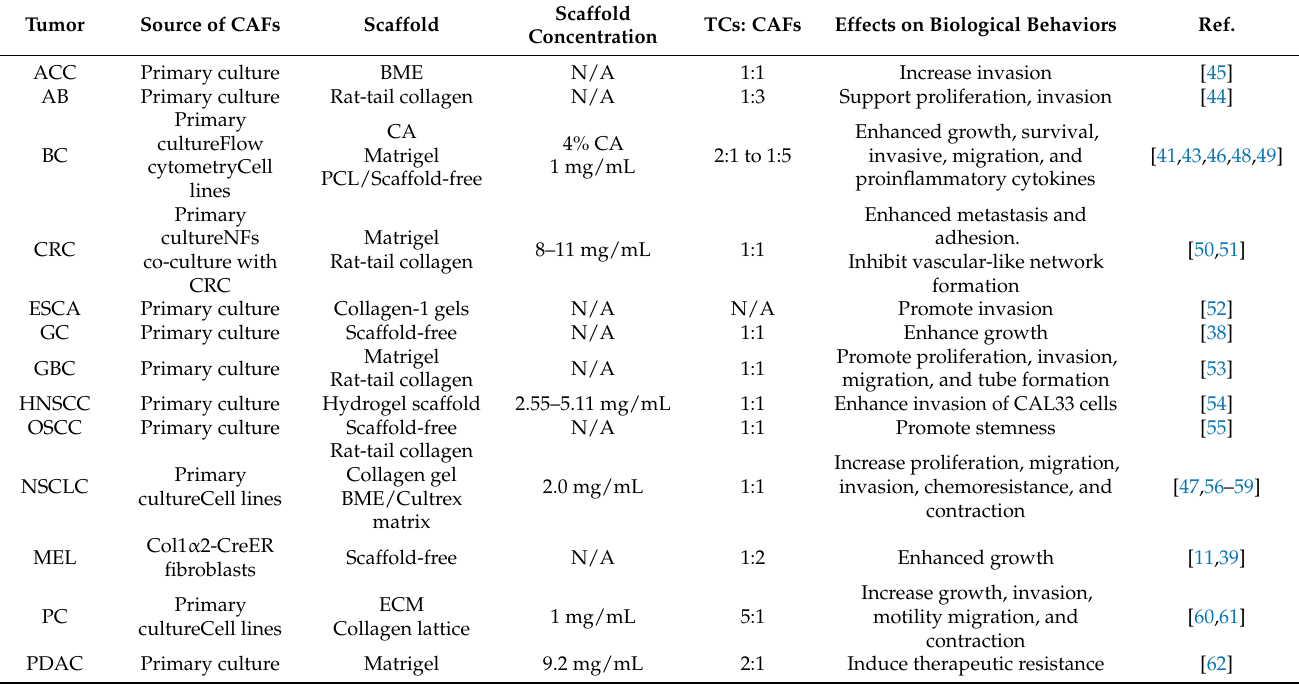
Table 2. 3D co-culture in the cancer-associated fibroblasts in